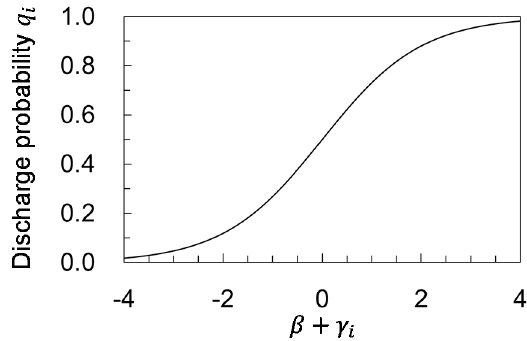
Figure 3. Growth curve representing relationship between discharge probability and parameters used in variable discharge probability model.